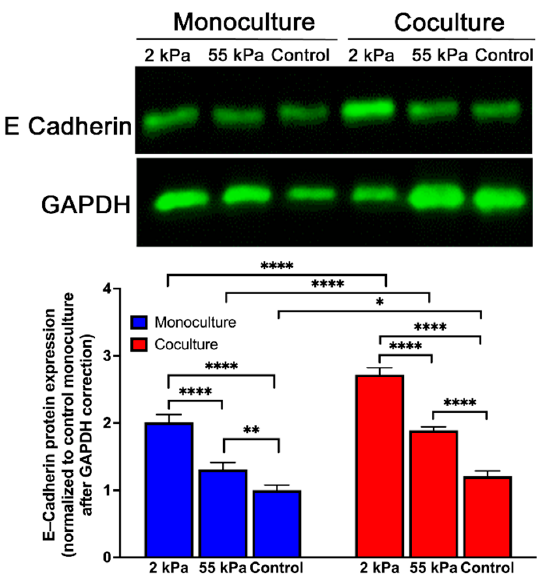
Figure 5. Expression of E-cadherin in hepatocytes cultured on PDMS gels. Western blot and